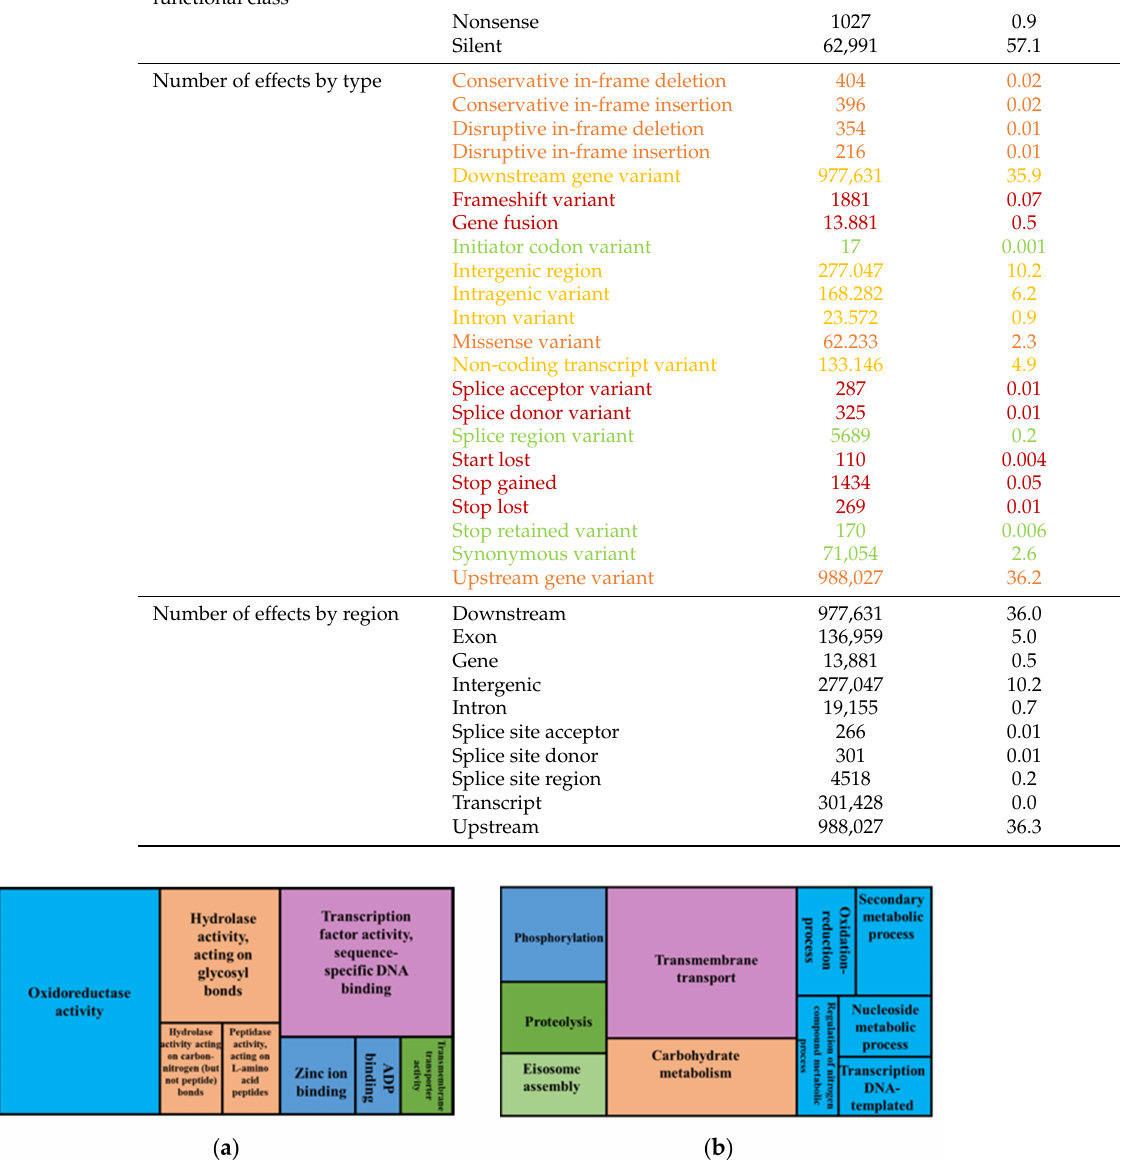
Figure 7. GO enrichment analysis for genes within high variant density chromosomal regions showing overrepresented GO terms, biological processes ( a ) and molecular functions ( b ). The whole genome annotations of the reference FSP34 were used as the reference set, genes within high variant density regions were used as the test